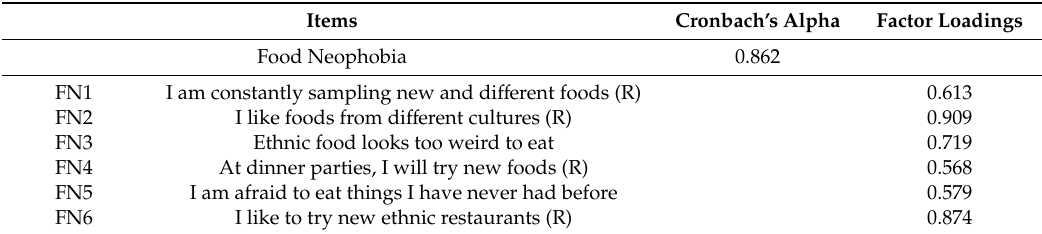
Table 3. Confirmatory factor analysis of the food neophobia (FN) construct.